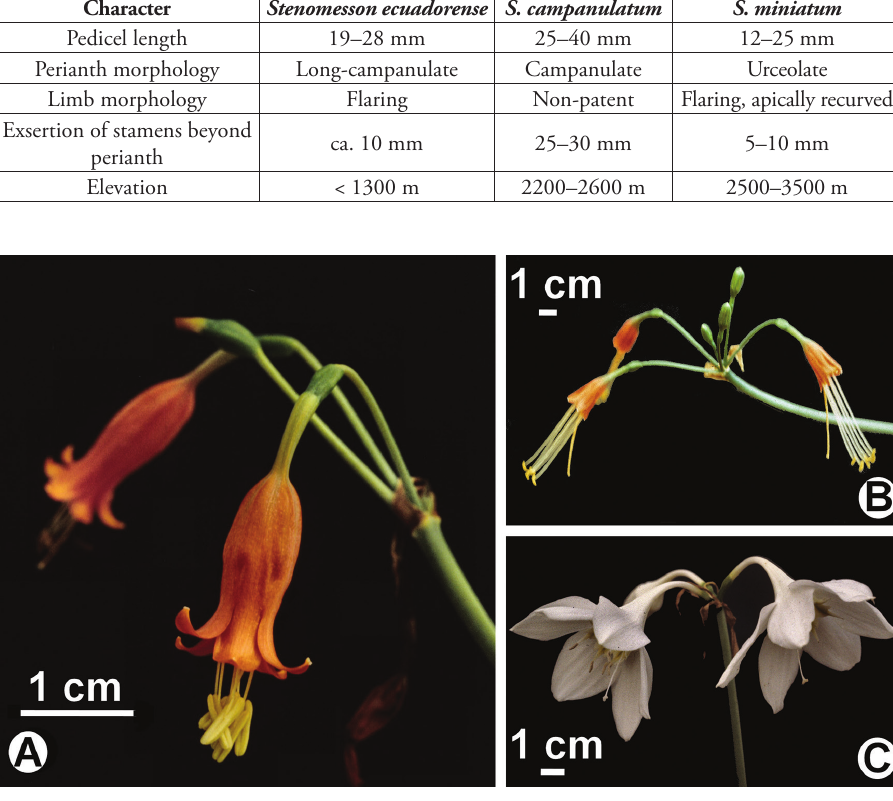
Figure 2. Species closely related to the new taxa described in this paper. A Stenomesson miniatum ( Meerow 1148, FTG) B S. campanulatum ( Meerow 2445 (NA) C Eucharis moorei ( Meerow & Meerow 1141,